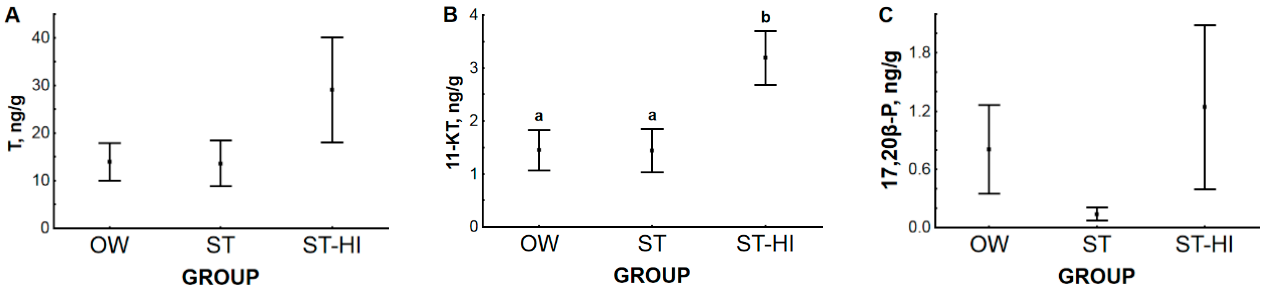
Figure 5. Testis level of: ( A ) testosterone (T, ng/g), ( B ) 11-ketotestosterone (11-KT, ng/g), ( C ) 17,20 β -dihydroxypren-4-en- 3-one (17,20 β -P, ng/g) in experimental groups of sterlet. OW—fish were held in fish-farming ponds (water temperature 2 °C); ST—fish were adapted to spawning temperature of 14 °C, spermiation was not induced; ST-HI—fish were adapted to spawning temperature of 14 °C, spermiation was induced. Dots represent the means, and whiskers represent the standard errors. Values with different letters are significantly different ( p < 0.05, multiple comparisons of mean ranks for all groups).